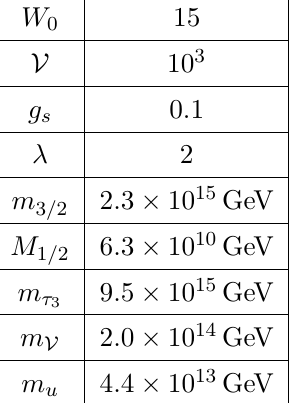
Table 2 . Benchmark spectrum for Fibre inflation. The gaugino mass M with ω = 0 . 01 and τ = 1 . 5 3